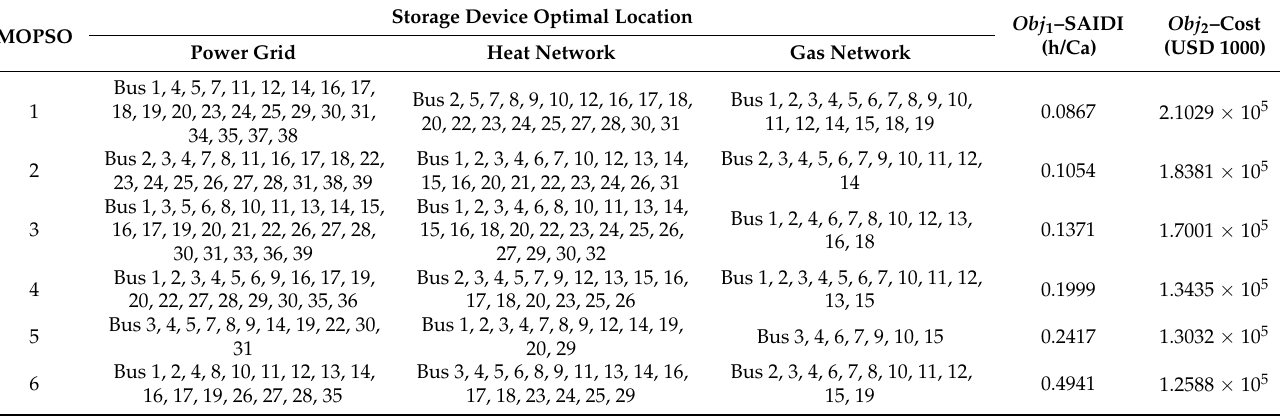
Table 8. MOPSO optimization result.